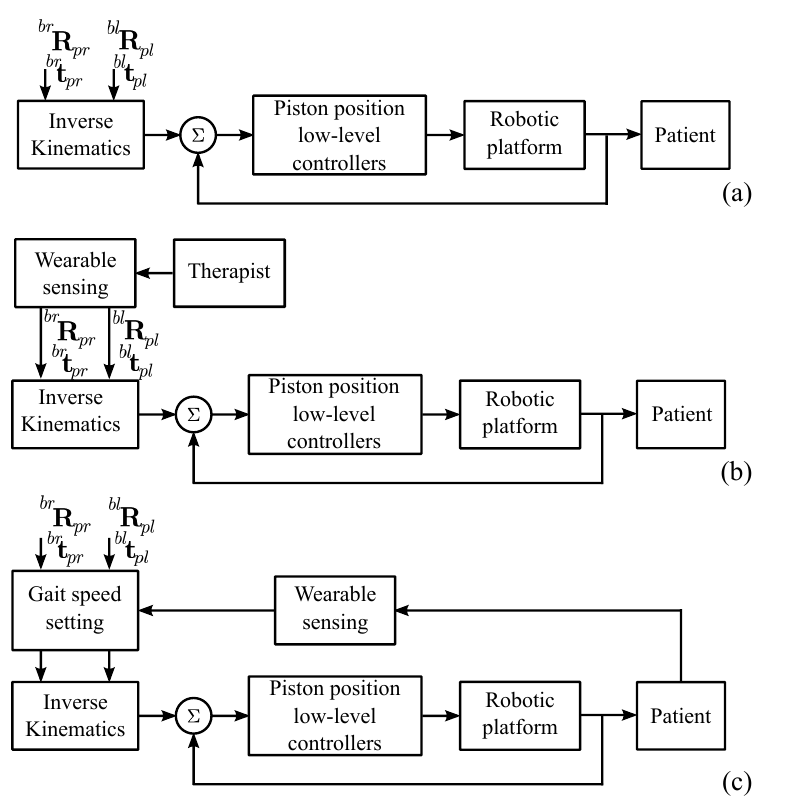
Figure 3. Control strategies for gait rehabilitation. ( a ) Represents the basic control strategy using fixed gait trajectories, and ( b , c ) depict the novel approaches described in this work, i.e., Therapist Modulation Mode (TMM) and Self-Modulation Mode (SMM),